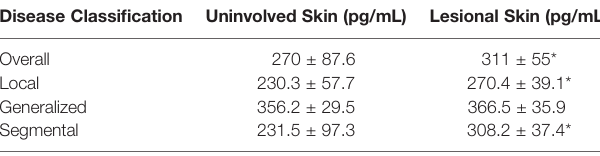
TABLE 2 | The concentrations of NPY in skin fl uids of vitiligo